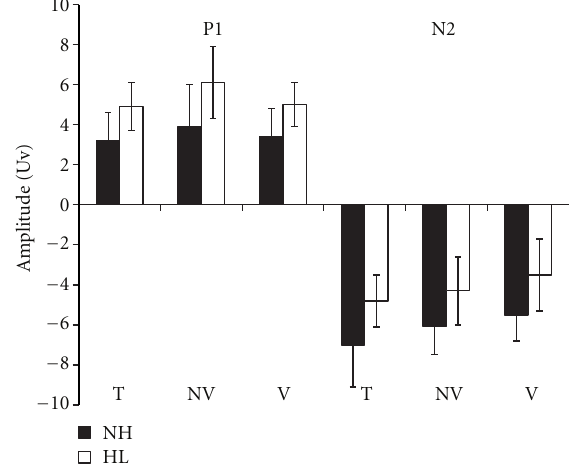
Figure 3: P1 and N2 mean amplitude values and standard deviation of five children with hearing loss (HL) and five children with normal hearing (NH) with 1 kHz pure tone (T), nonverbal /ba/ (NV), and verbal /ba/ (V)